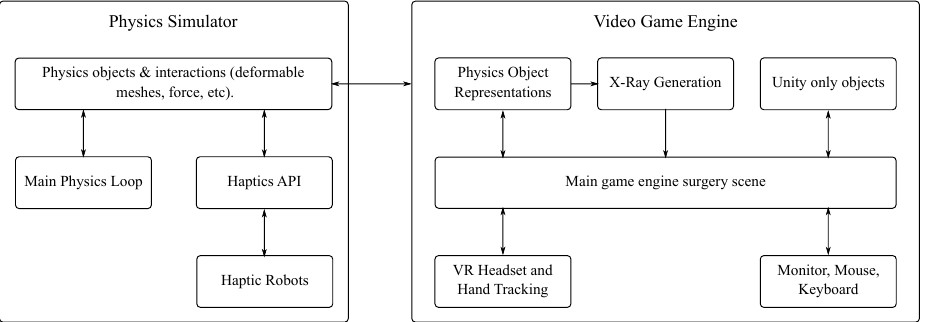
Figure 4. Flow chart of the interactions between the physics simulator, the game engine, and the peripherals to generate an immersive VR experience for